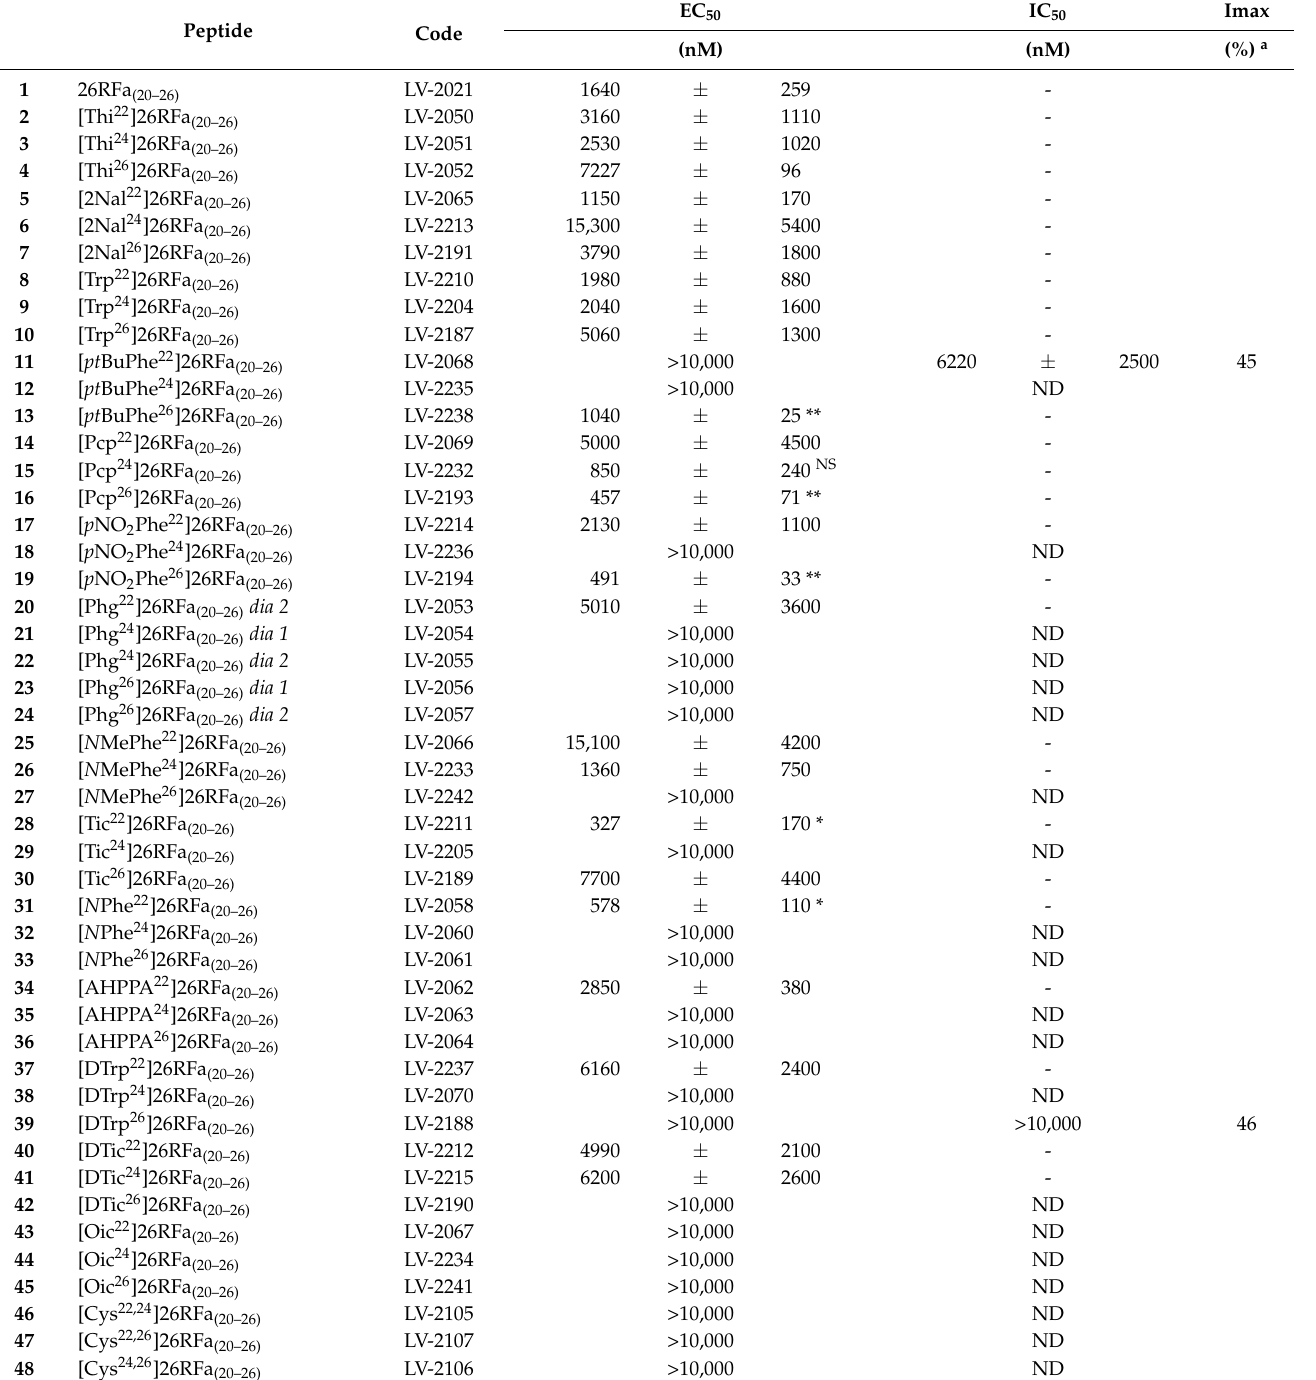
Table 2. Biological data for 26RFa (20–26) analogs substituted in positions 22, 24 and